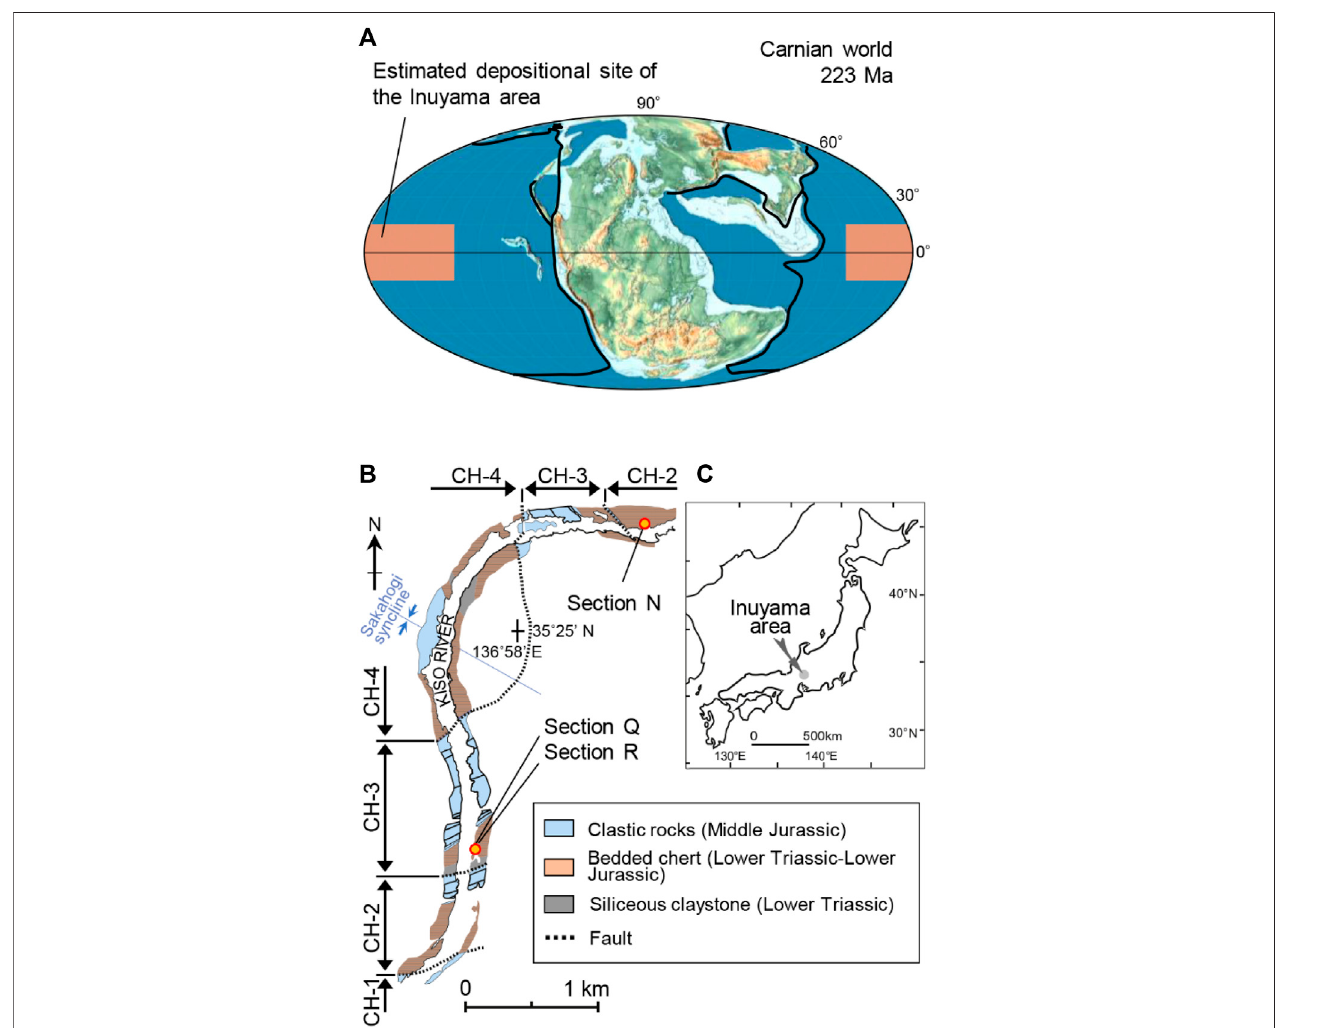
FIGURE1|(A) Carnianpaleogeography(modi fi ed after Scotese, 2014).The shaded region showsapossible areawithinwhichthe Inuyama succession waslikely deposited. Subduction zones are shown in black lines (from Matthews et al., 2016) (B) Geologic map and (C) location map showing the location of the Carnian bedded chert successions in Inuyama area, central Japan (modi fi ed after Kimura and Hori, 1993).